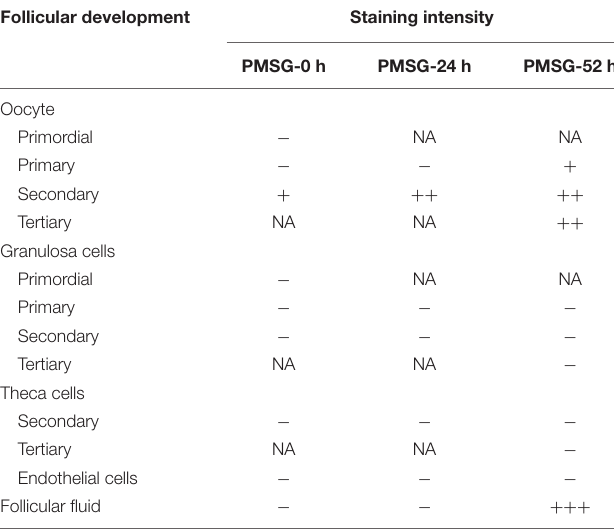
# P < 0.05, vs. PMSH-0 h; & P < 0.05, vs. PMSH-24